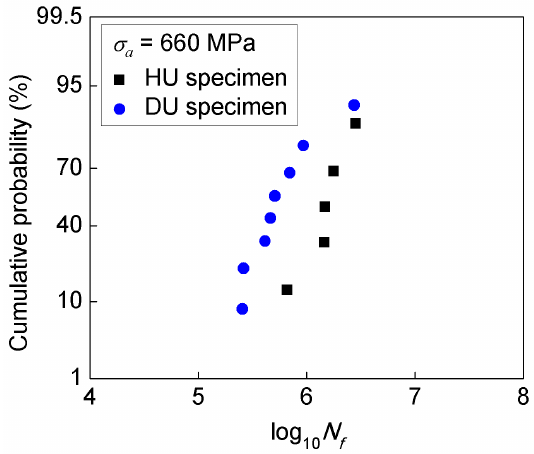
Figure 8. Cumulative probability of fatigue life in logarithmic scale for specimens under ultrasonic fatigue test.